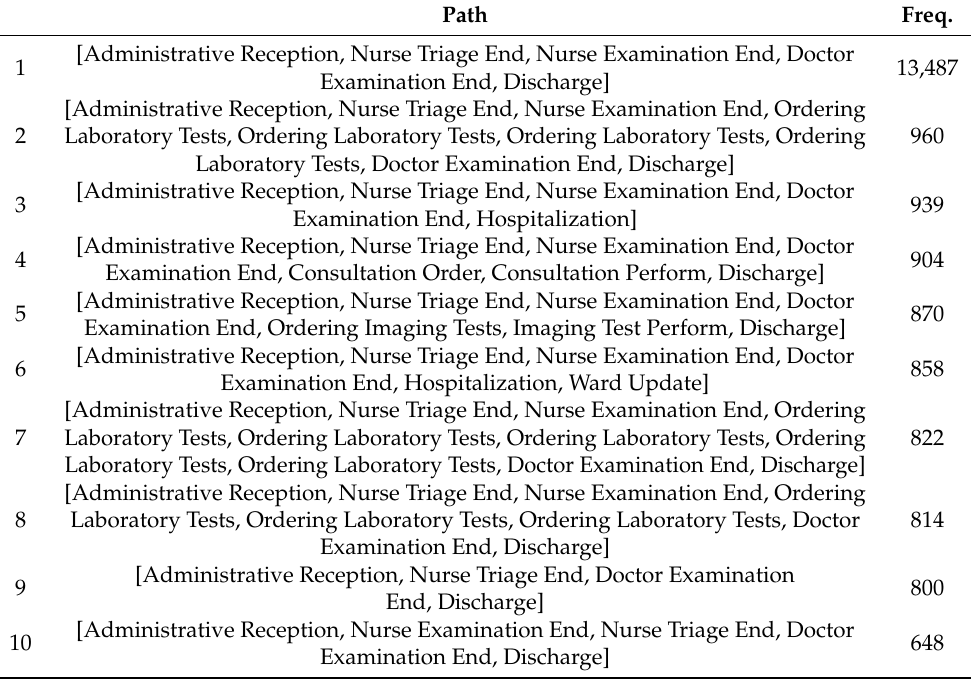
Table 3. Top 10 most frequent journey sequences in the hospital ED network. Path